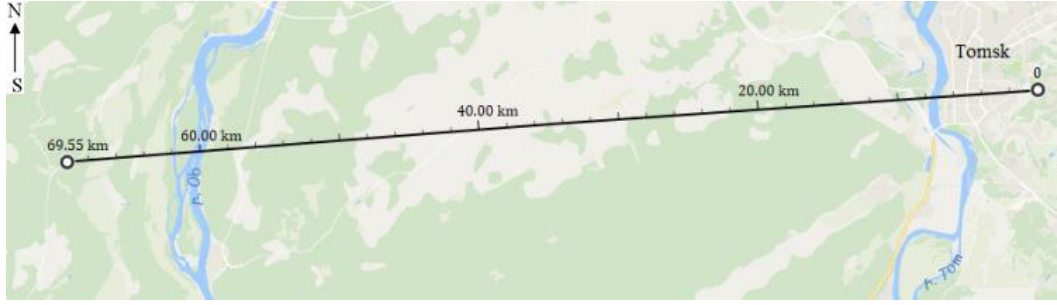
Figure 5. Map illustrating the geometry of our experiment in the visible wavelength range performed in the Tomsk region (Russia).